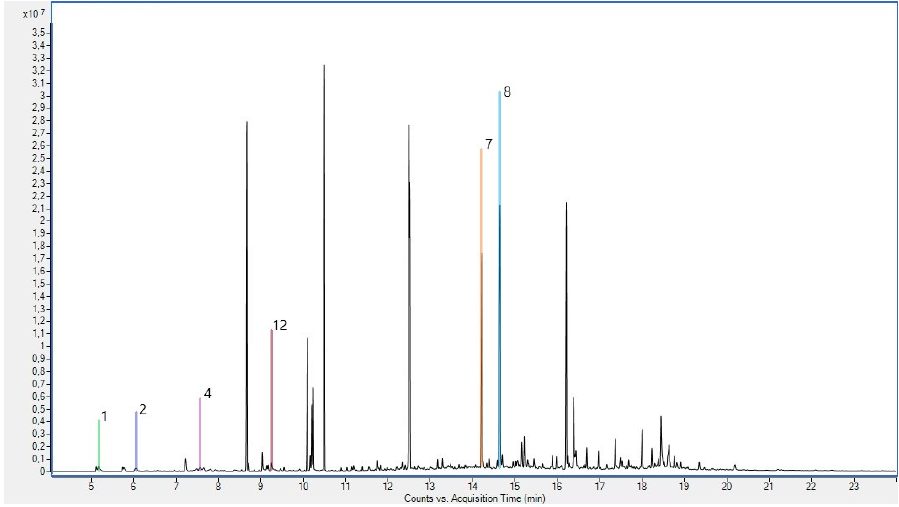
Figure 4. Chromatogram of DCM extraction of sample X with # ID.